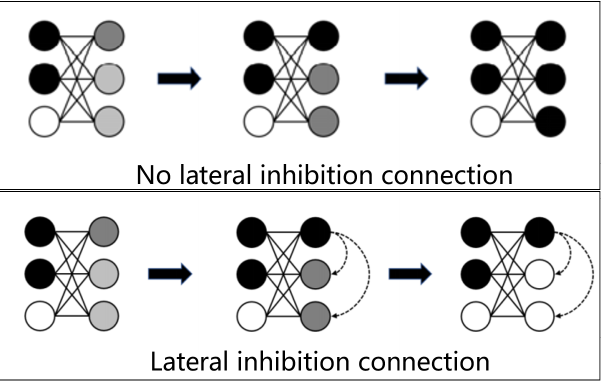
Figure 2. Schematic diagram of lateral inhibition connection. The color depth of the circle indicates the membrane potential of the neuron, the darker the color, the higher the membrane potential, and the black color indicates the pulse. The dotted lines are inhibitory synaptic connections.